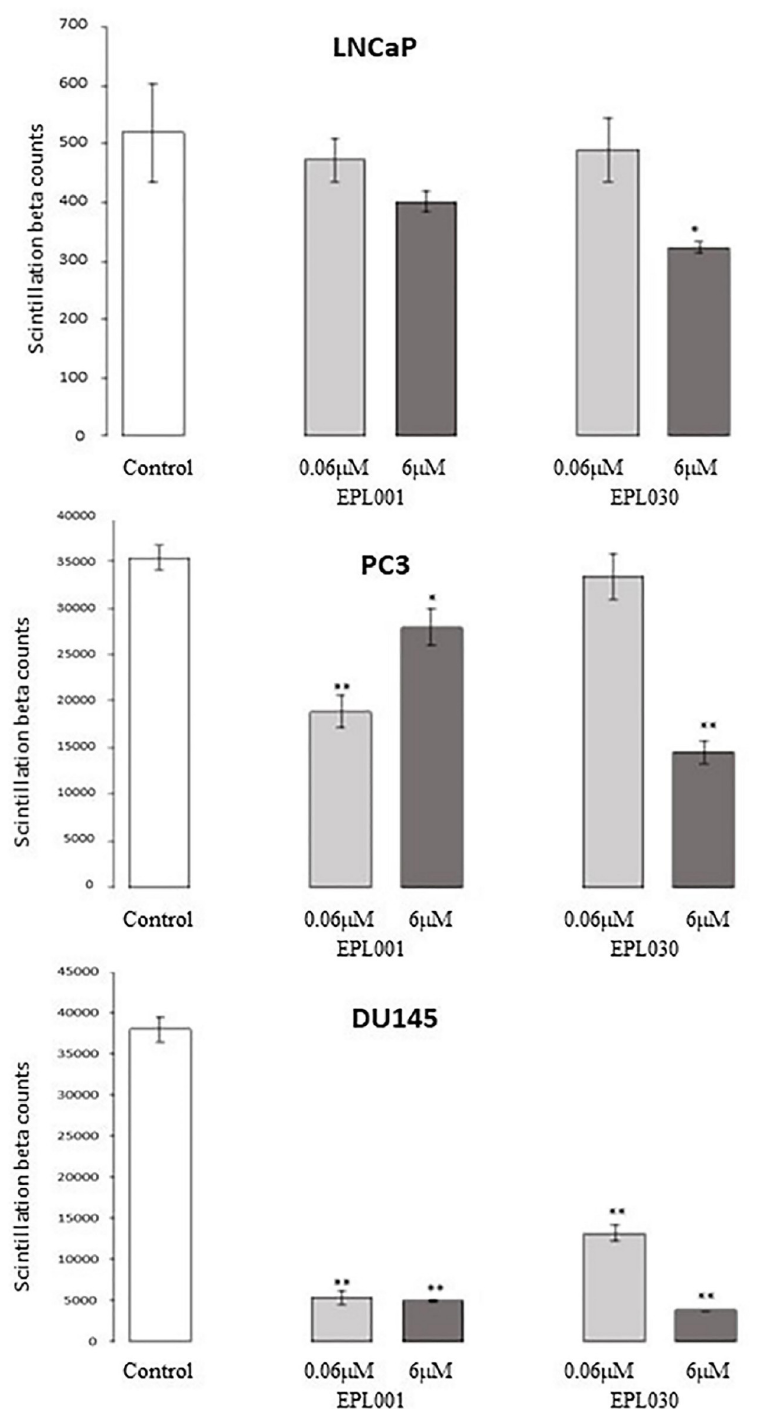
Fig 4. EPL001 and EPL030 effects on human prostate cancer cell growth in vitro. Cell proliferation was determined by 3 H-thymidine incorporation. Cells were treated with the 14mer EPL001 or its scrambled-sequence control EPL030 at 0.06 or 6 μ M (or given solvent control) for 24h before being pulsed for 48h with 1 μ Ci/ml 3 H-thymidine. Data are scintillation beta counts, mean +/-SD of the average values from three independent experiments performed in triplicate (n = 9), with statistical analysis by two tailed t -test. � p < 0.05; �� p < 0.0001.